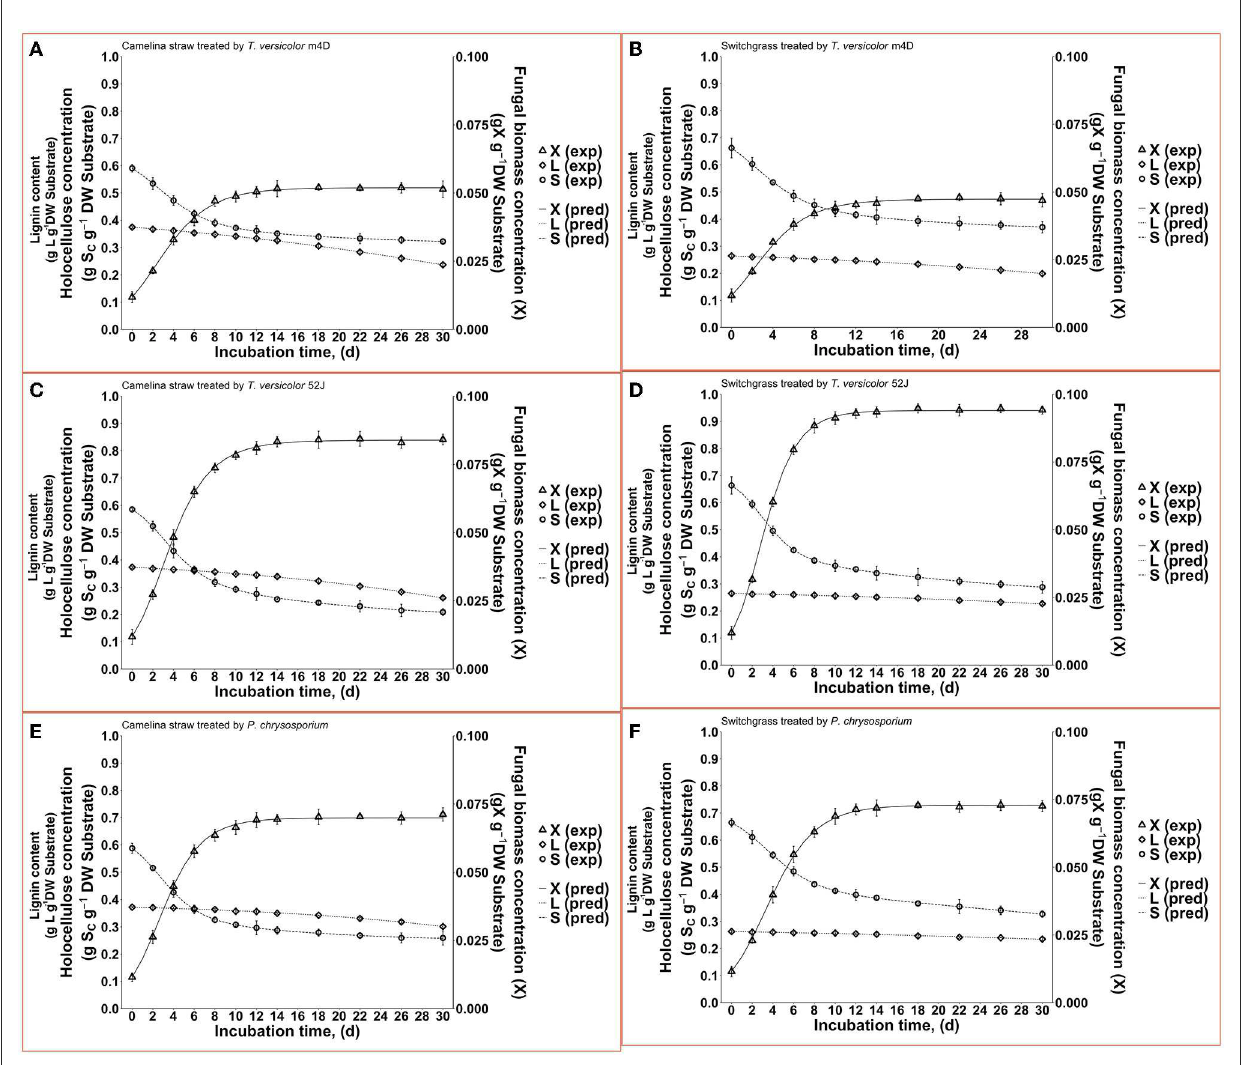
FIGURE4 Time profiles of fungal biomass, holocellulose, and lignin concentration during 30 d of microbial pretreatment: (A) : profiles of TVm4D on CS, (B) : profiles of TVm4D on SG, (C) : profiles of TV52J on CS, (D) : profiles of TV52J on SG, (E) : profiles of PC on CS, (F) : profiles of PC on SG. X, fungal biomass; L, lignin; S, holocellulose; exp, observed data from the experiment; pred, predicted values calculated by the proposed models.